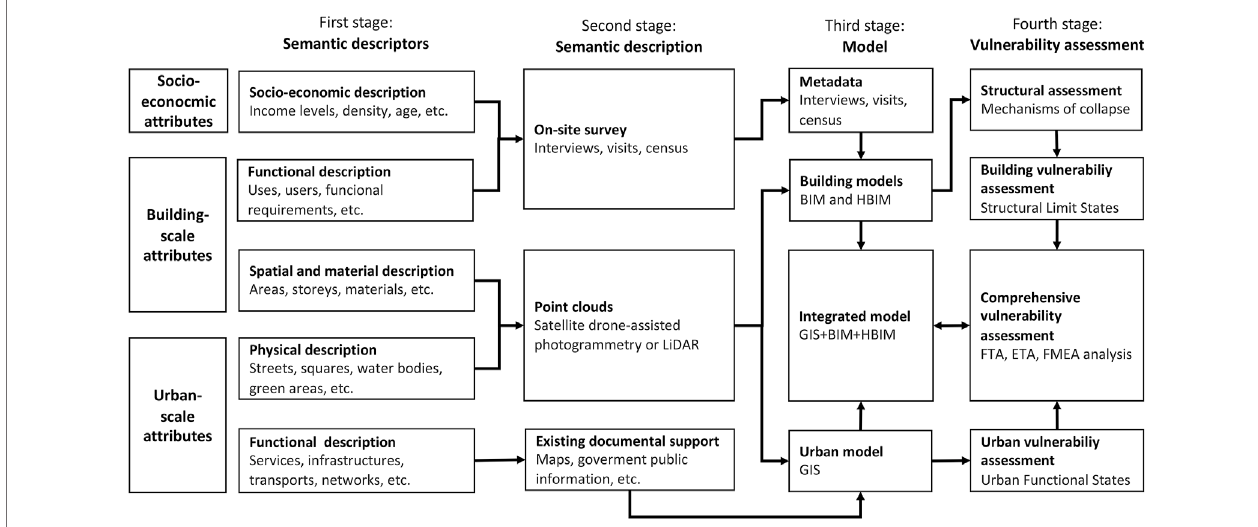
FIGURE 3 | Potential multi-scale integration for data-acquisition. Four main stages are considered in this framework for characterising the urban environment: Selectionofdescriptors,surveyingprocesses,modellingandassessment.Themodelalsocontemplatesamulti-scaleclassi fi cationforeachstep.AdaptedfromRamírez Eudave and Ferreira (2020).